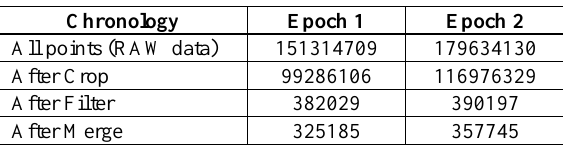
Table 2. The chronology of the mobile laser scanning data processing tasks